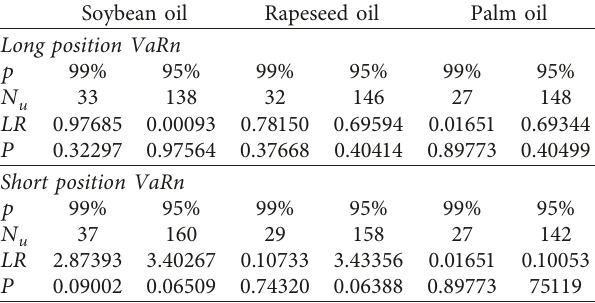
Table 10: VaRn backtesting results. Soybean oil Rapeseed oil Palm oil